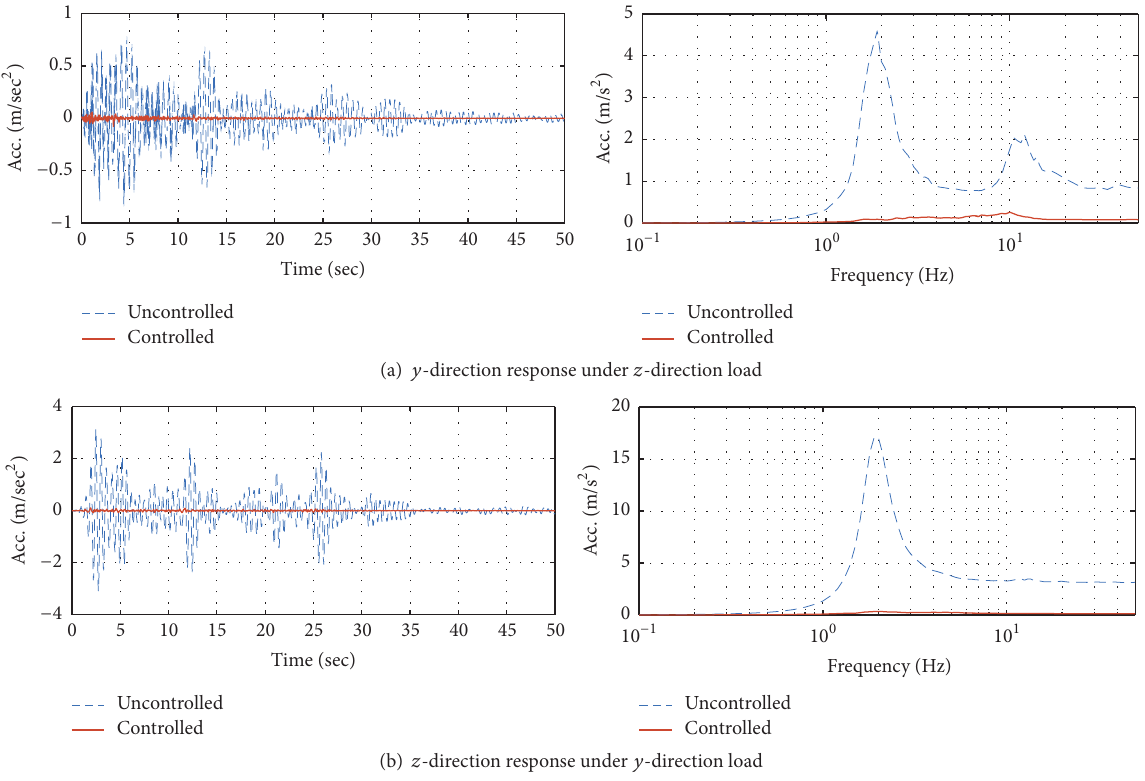
Figure 17: Response of piping system subjected to El Centro earthquake.